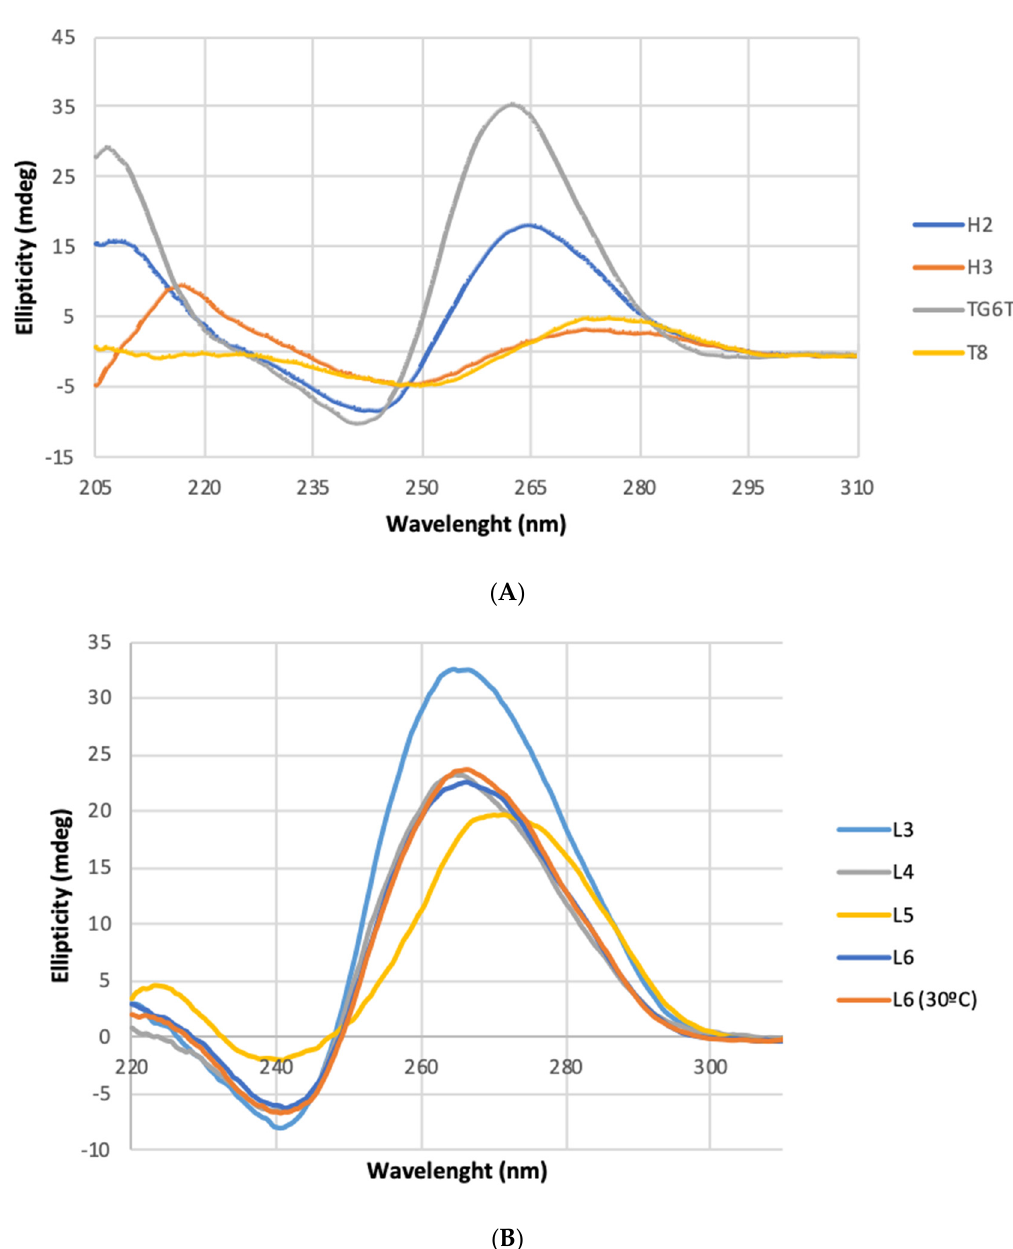
Figure 1. ( A ) CD spectra of G-rich sequence (G − PO − HCV − L235, H2) versus A-rich sequence (A − PO − HCV − L235, H3). The CD spectra of TG 6 T and T 8 are included for comparison. Buffer conditions PBS 1×. ( B ) CD spectra of G-rich sequences carrying the antiluciferase sequence (L3, L4, L6) versus the control T-rich sequence (L5) Buffer conditions PBS 1×.